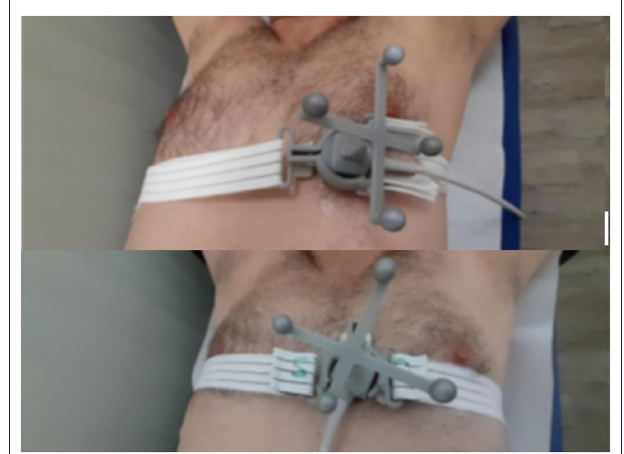
FIGURE 1 | Images of the ultrasound probe housed in the holder containing the markers for optical localization. The probe and the support are kept adherent to the patient’s chest by means of an adjustable elastic band. Upper panel apical position; Lower panel parasternal